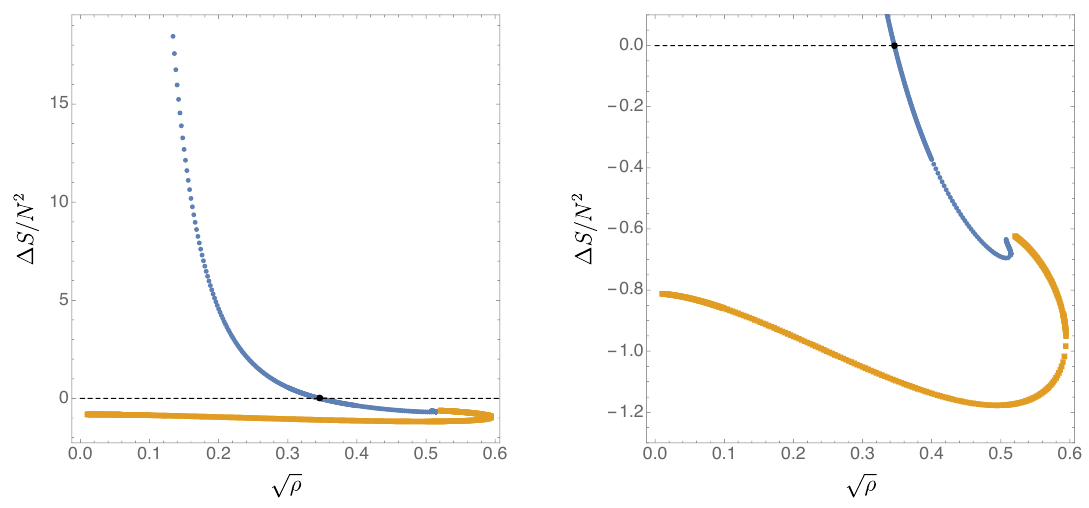
Figure 10 . The entropy of various phases with (cid:12)xed SAdS 4 boundary metric parametrised by (cid:26) : the orange squares represent the droplets and the blue disks the funnels. The right panel shows a close-up of the region close to the merger point where the funnel and droplet families appear to meet. The black disk represents the transition between stable and unstable non-uniform funnels.